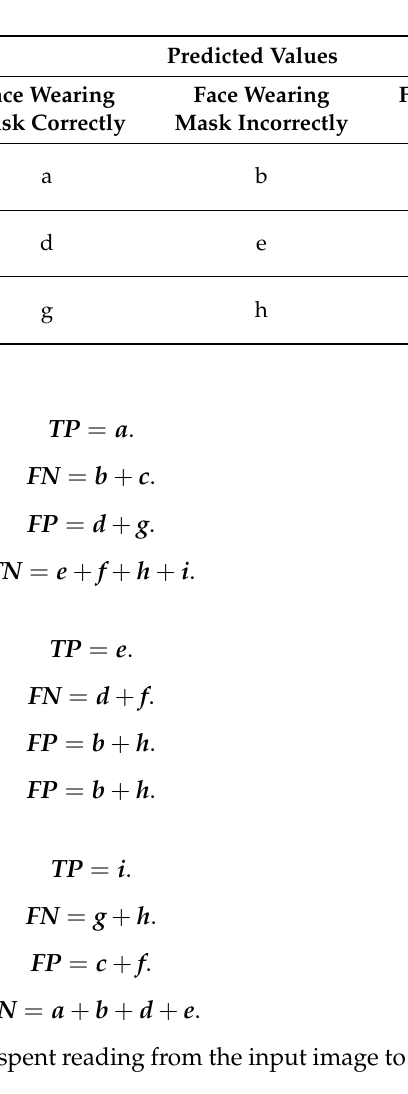
Table 1. Confusion